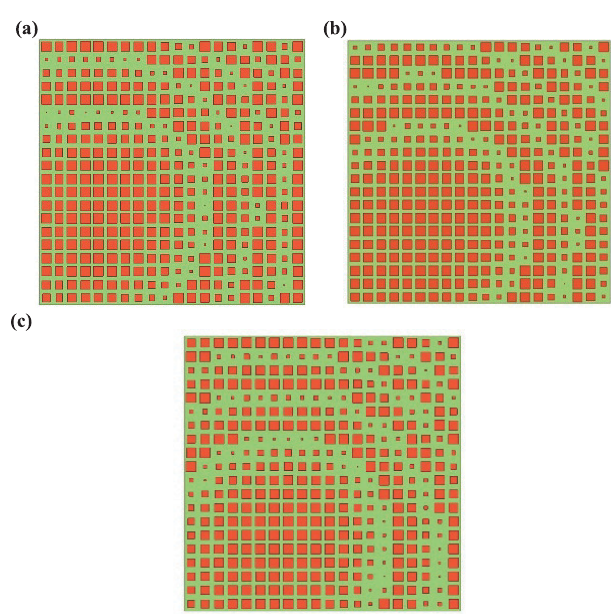
Fig. 13. Designed MNMS structure for different main beam directions at (a) u = 30 ° , f = 30 ° , (b) u = 30 ° , f = 45 ° , and (c) u =30 ° , f = 60 °